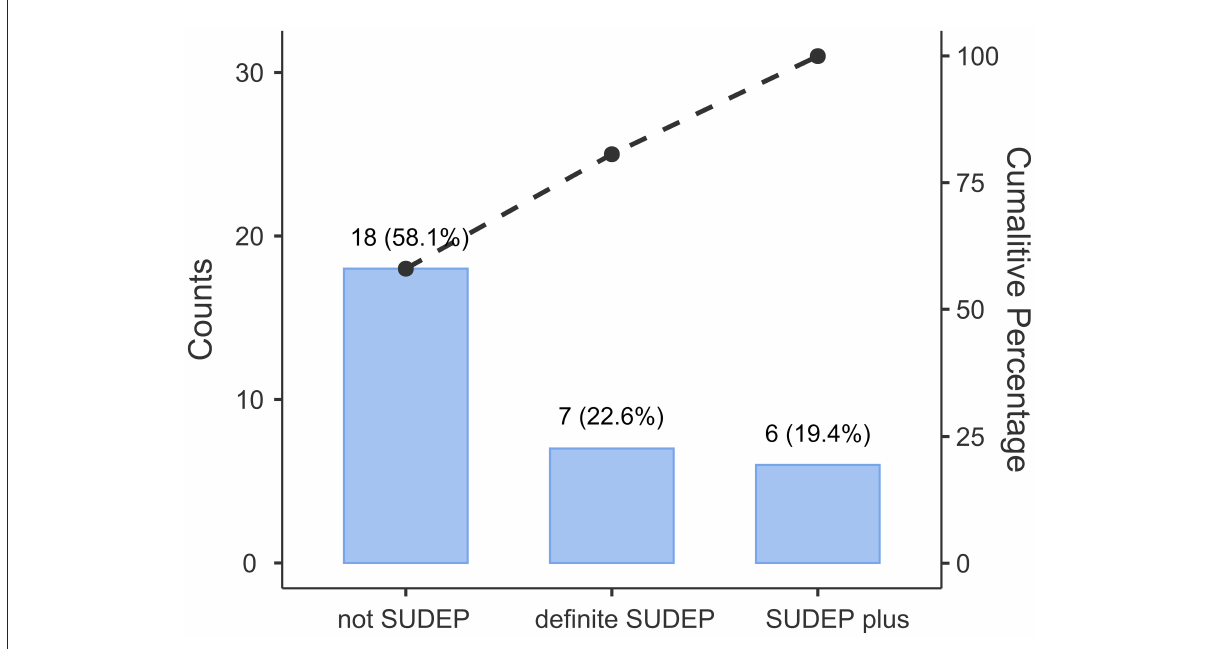
FIGURE1 Classification of the collected 31 cases and the respective